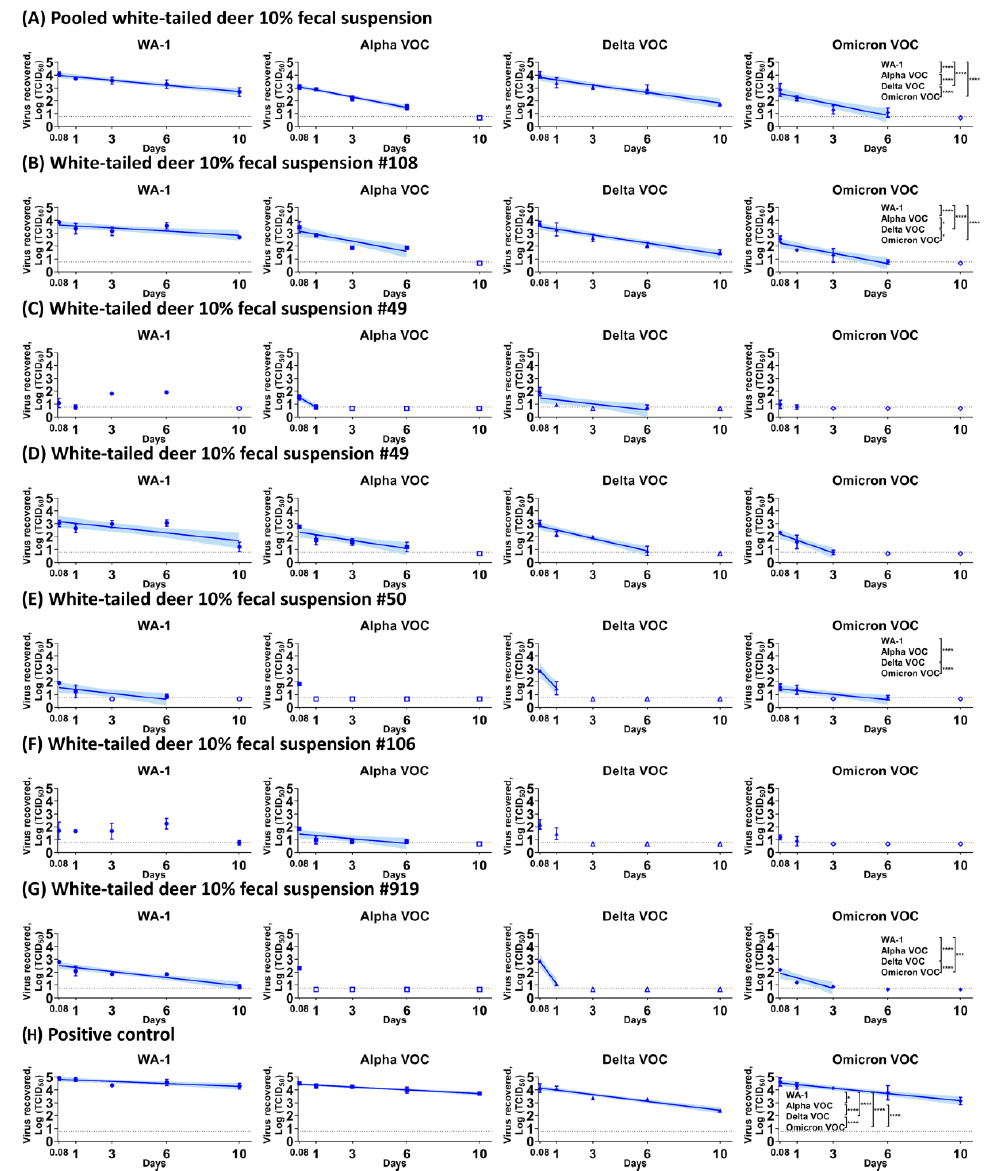
Figure 3. Stability of SARS-CoV-2 WA-1 strain and variants of concern in white-tailed deer 10% fecal suspension. A total of 3.1 × 10 4 TCID 50 of WA-1, Alpha, Delta, and Omicron VOCs were mixed with fecal suspensions obtained from different white-tailed deer ( A – G ) or medium alone ( H ) as a positive control and incubated under winter conditions. At each time point, virus was recovered and titrated on Vero-TMPRSS2 cells. The simple linear regression was estimated to calculate the half-life value and compare the values among strains using ANOVA and subsequent post hoc Tukey’s test. The virus titer is represented as the mean and standard deviation of log-transformed TCID 50 , and the colored line and their shaded areas represent a best-fit line and 95% confidence interval of the simple linear regression. Adjusted p -values for significance are marked: * ( p < 0.05), *** ( p < 0.001), and **** ( p < 0.0001). On the x-axis, 0.08 is equal to 2 h. Pooled feces were collected on the animal room floor and mixed in PBS to prepare pooled 10% fecal suspension ( A ). Feces was collected from the anus of individual deer at 4 ( B ), 14 ( C ), and 18 ( D – G ) days post-challenge and mixed in PBS to prepare pooled 10% fecal